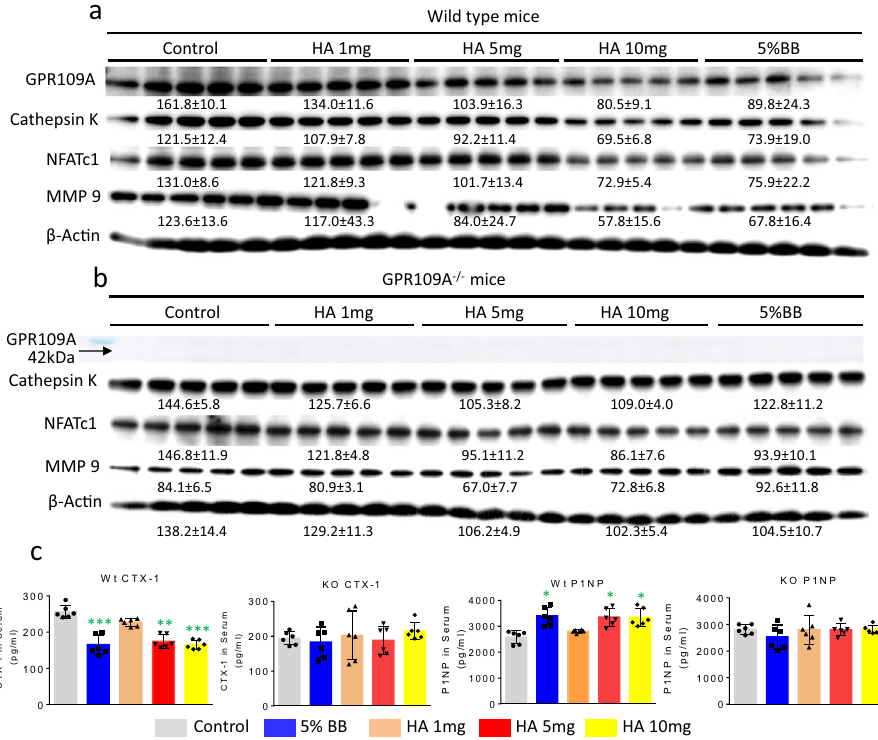
Fig. 8 HA and 5% BB diet inhibit GPR109A expression and bone resorptive signals in ten weeks old wild type but not in GPR109A − / − male mice. Proteins were isolated from aspirated femur bone marrow cells, 5 per group from 4-weeks-old wild type or GPR109A − / − mice with or without BB or HA treatments for six weeks. a Western blot shows HA and BB diet inhibited GPR109A protein expression, and osteoclast bone resorptive markers Cathepsin K, NFATc1 and MMP9 protein expression in samples from wild type mice. b Western blot shows HA and BB diet did not change osteoclast bone resorptive markers Cathepsin K, NFATc1 and MMP9 protein expression in samples from GPR109A − / − mice compared with samples from untreated GPR109A − / − mice. c CTX-1 and P1NP levels in serum from wild type (Wt) and GPR109 − / − (KO) mice. Data are expressed as mean ± SD ( n = 6 per group); * p < 0.05, ** p <0.01, *** p <0.001, as determined by one-way ANOVA followed by Student-Newman-Keuls posthoc analysis for multiple pairwise comparisons to